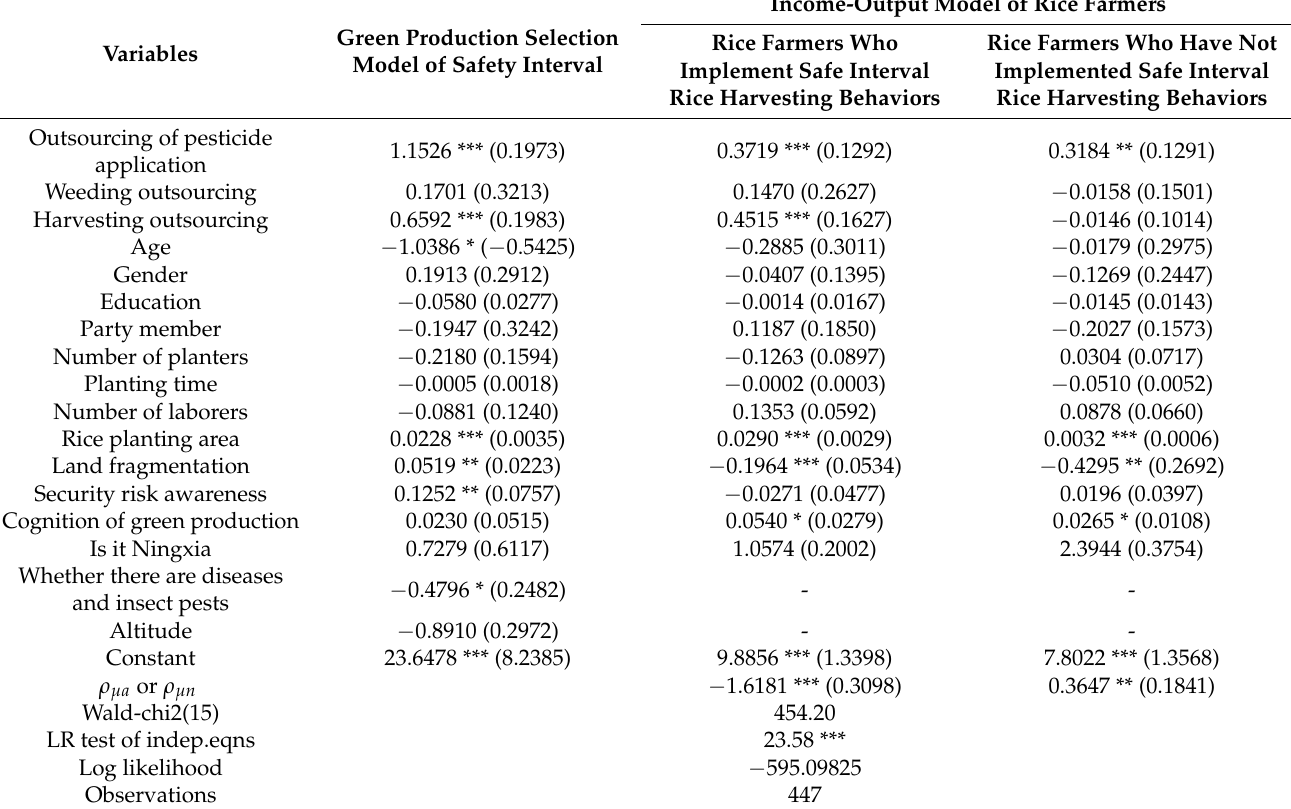
Table 7. Simultaneous estimation results of green production behaviors model and rice income-output model in safety